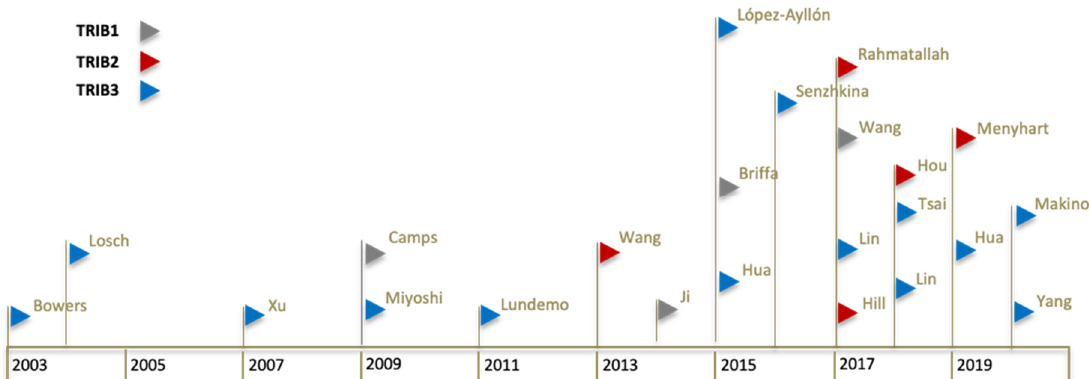
Figure 1. Timeline of Tribbles publications in colorectal cancer. Chronological representation of each significant publication. Each publication is represented by a coloured flag symbol ( ). Flag colours are associated with a different Tribble family member (TRIB1 in grey flag, TRIB2 in red flag, and TRIB3 in blue flag). First author last name is shown for each flag. A total of four articles studying or including TRIB1 , five for TRIB2 , and 14 for TRIB3 , in colon cancer, were identified from 2003 to 2020 and are included in the